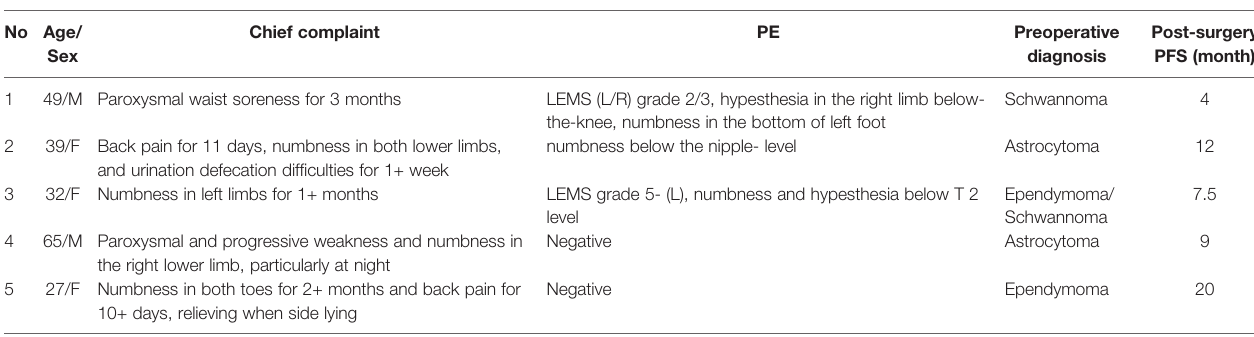
TABLE 1 | Clinical